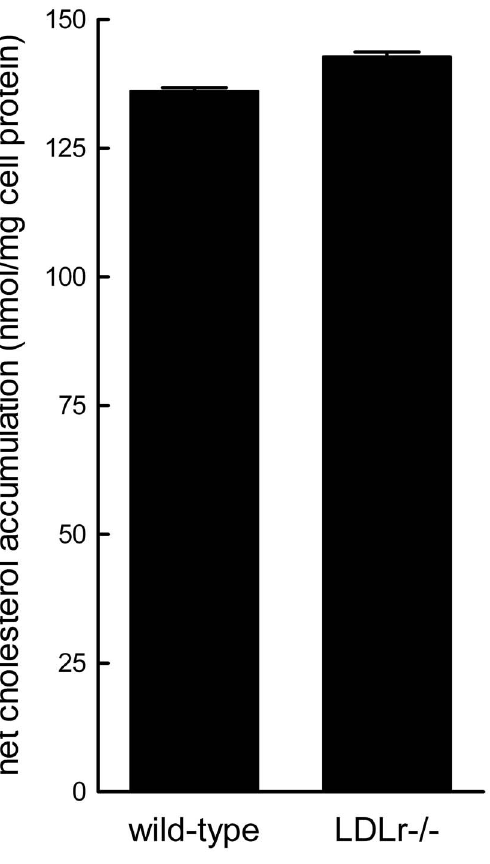
Figure 5. Wild-type and LDL 2 / 2 macrophages incubated with LDL accumulate similar levels of cholesterol. Wild-type and LDLR 2 / 2 macrophages were incubated with 1 mg/ml LDL for 24 h and then total cholesterol accumulation was assessed. The baseline cholesterol levels for wild-type and LDLR 2 / 2 macrophages were 107 6 10 nmol cholesterol/mg protein and 122 6 9 nmol cholesterol/mg protein, respectively.